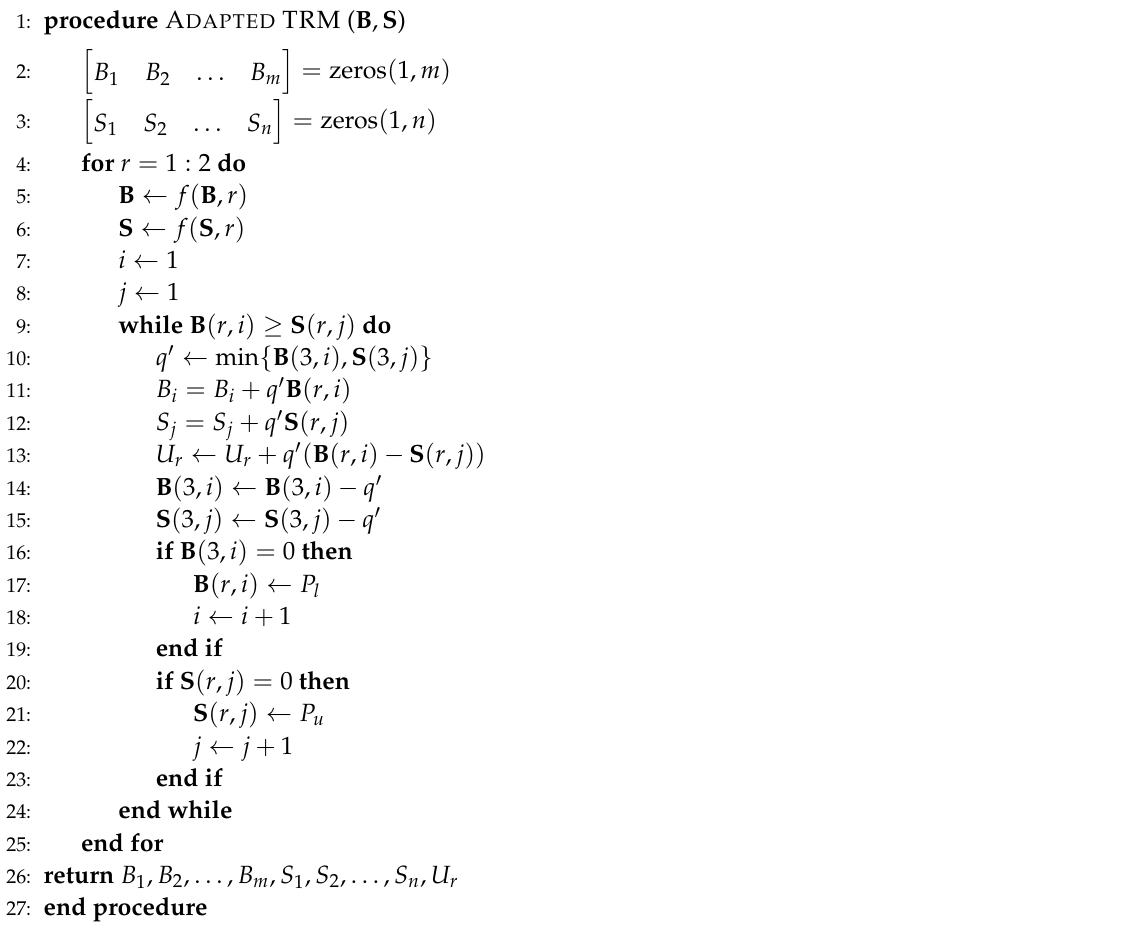
Algorithm 1 Adapted Trade Reduction Mechanism (TRM)